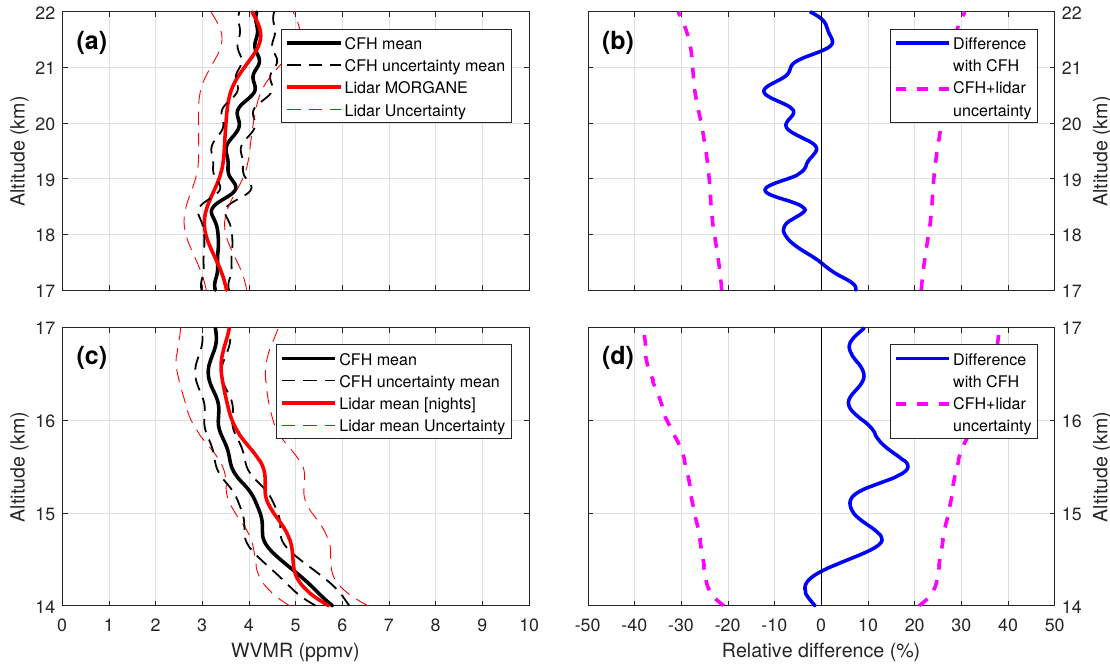
Figure 6. Comparison of the lidar and CFH water vapor mixing ratio during MORGANE in the UT/LS, between 14 km and 22 km. On the left ( a – c ): superimposition of the mean CFH water vapor profile (thick solid black line) with the lidar profile (solid red line). At the bottom left ( c ): mean lidar profile of the night sessions between 14 and 17 km asl and, at the top left ( a ): the lidar profile integrated over the whole campaign data between 17 and 22 km asl. The red dotted line represents the ± 1 σ lidar total uncertainty and the black dotted line represents the CFH uncertainty. On the right ( b – d ): relative difference (in %) between the lidar and the mean CFH profile, between 14 and 17 km ( d ) and between 17 and 22 km ( b ). CFH data are taken as reference. The sum of CFH and lidar uncertainties is indicated with the magenta dotted